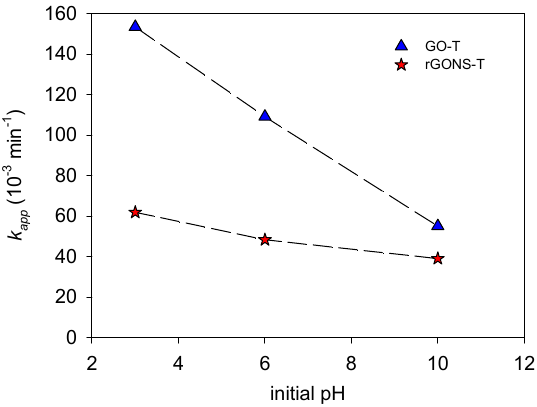
Figure 6. Pseudo-first order kinetic rate constant ( k app ) for different initial solution pH over the GO-T and rGONS-T composites.